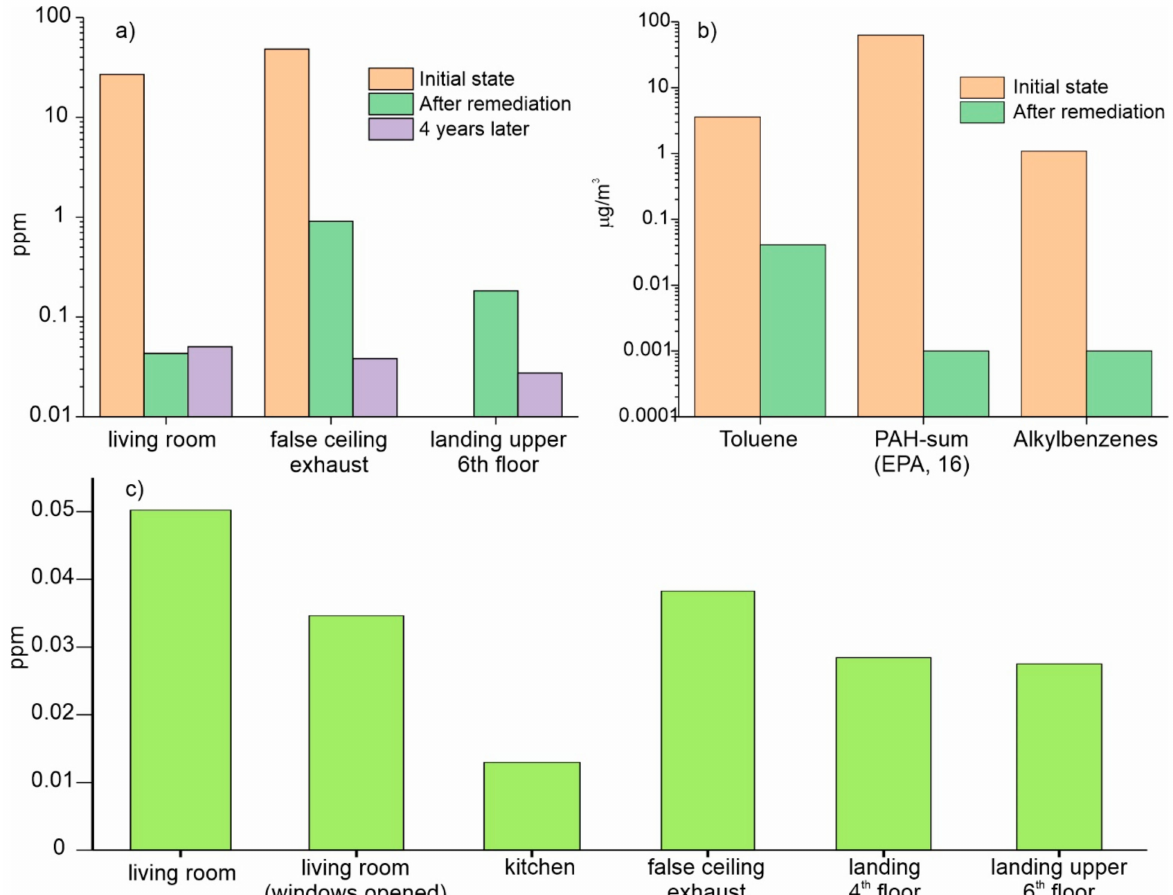
Figure 7. Graphical comparison of the results in the three inspections ( a ) PID readings (isobutylene equivalent concentration), ( b ) the amount of different type of air-borne compounds in the living room ( µ g/m 3 ), ( c ) PID readings 4 years after the remediation tests at different